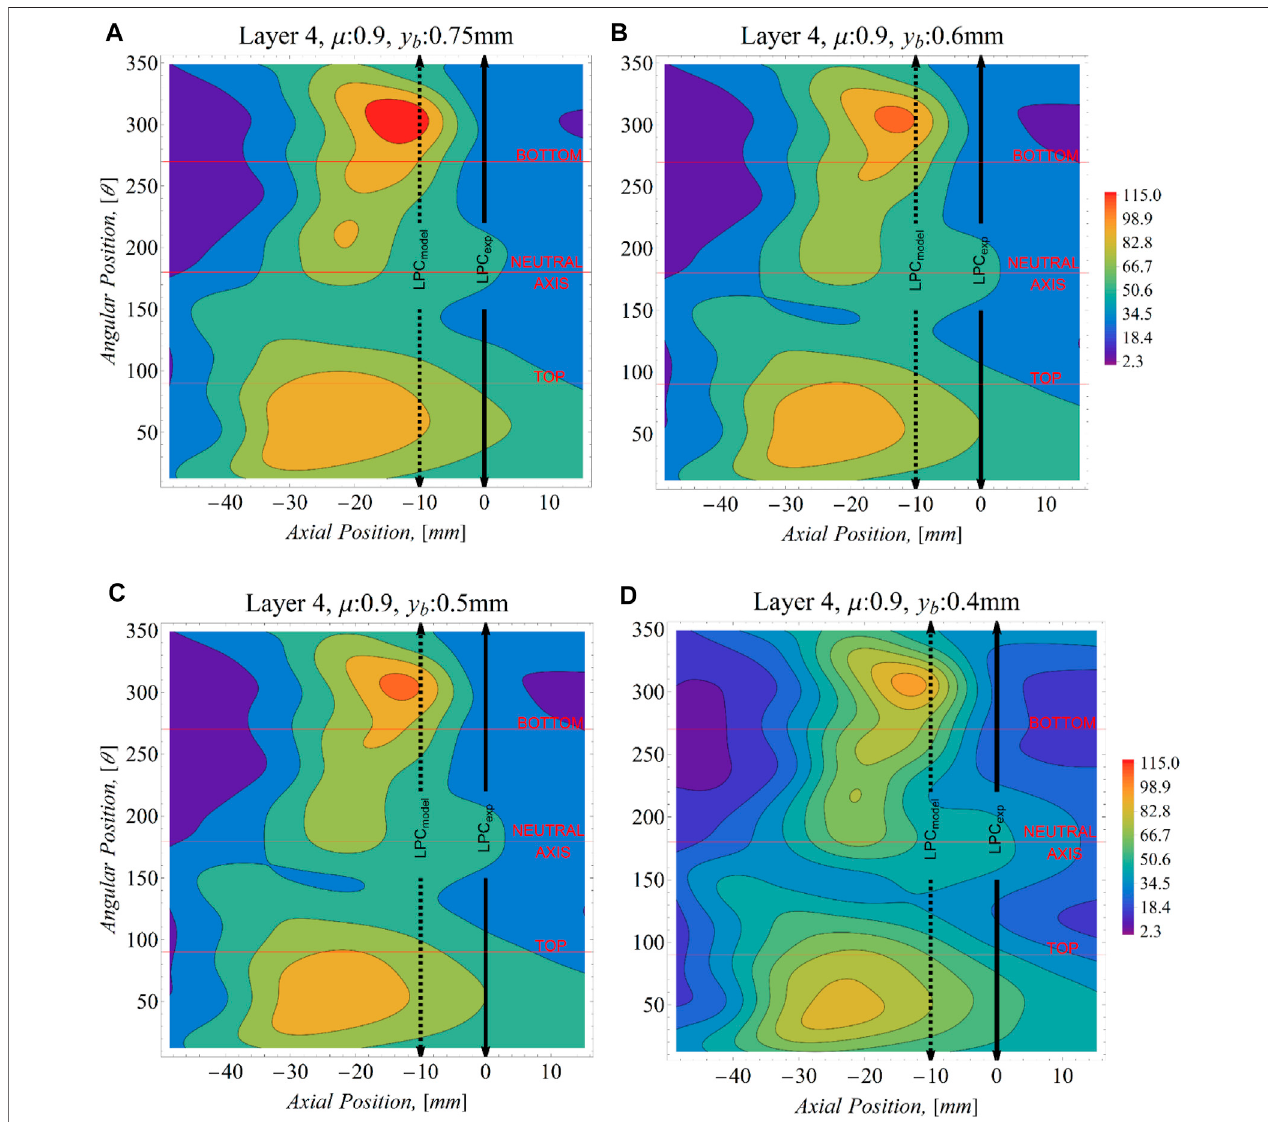
FIGURE 12 | Maximum SWT distribution on the wires of layer 4 of the Bersfort conductor. (A) bending amplitude of 0.75 mm. (B) bending amplitude of 0.6 mm (C) bending amplitude of 0.5 mm (D) bending amplitude of 0.4 mm. Units of the SWT are in MPa.